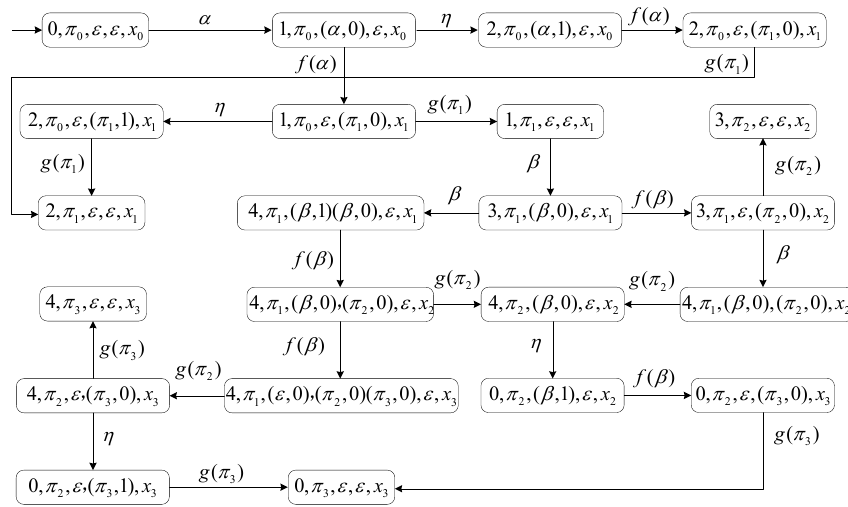
Figure 4. Automaton model G S in Example 2.